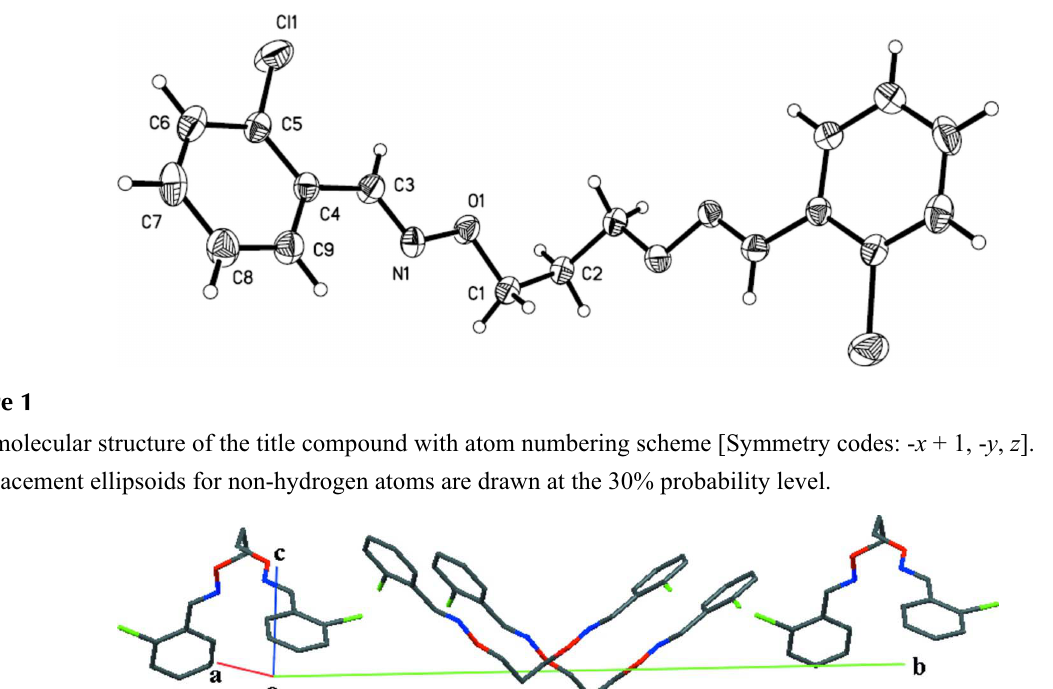
The V shape configuration of the title